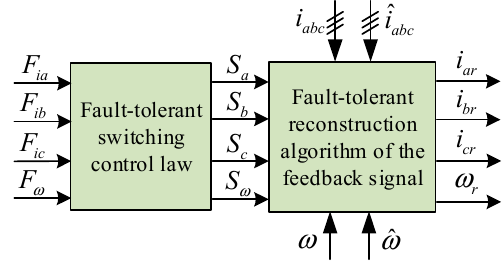
Figure 2. The block diagram of active fault-tolerant control.